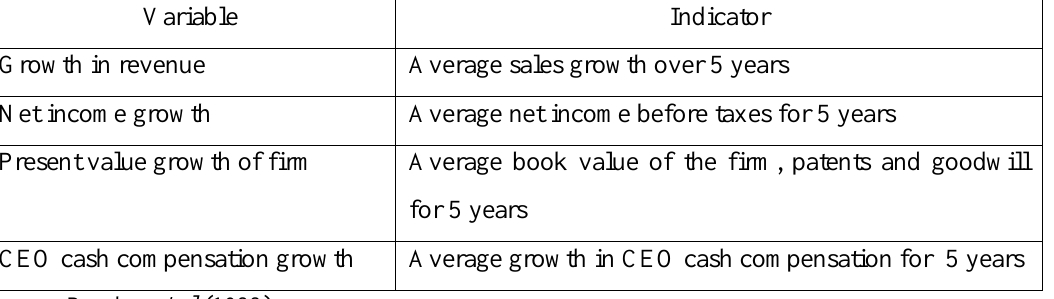
Table 1: Measures of Financial Performance Variable